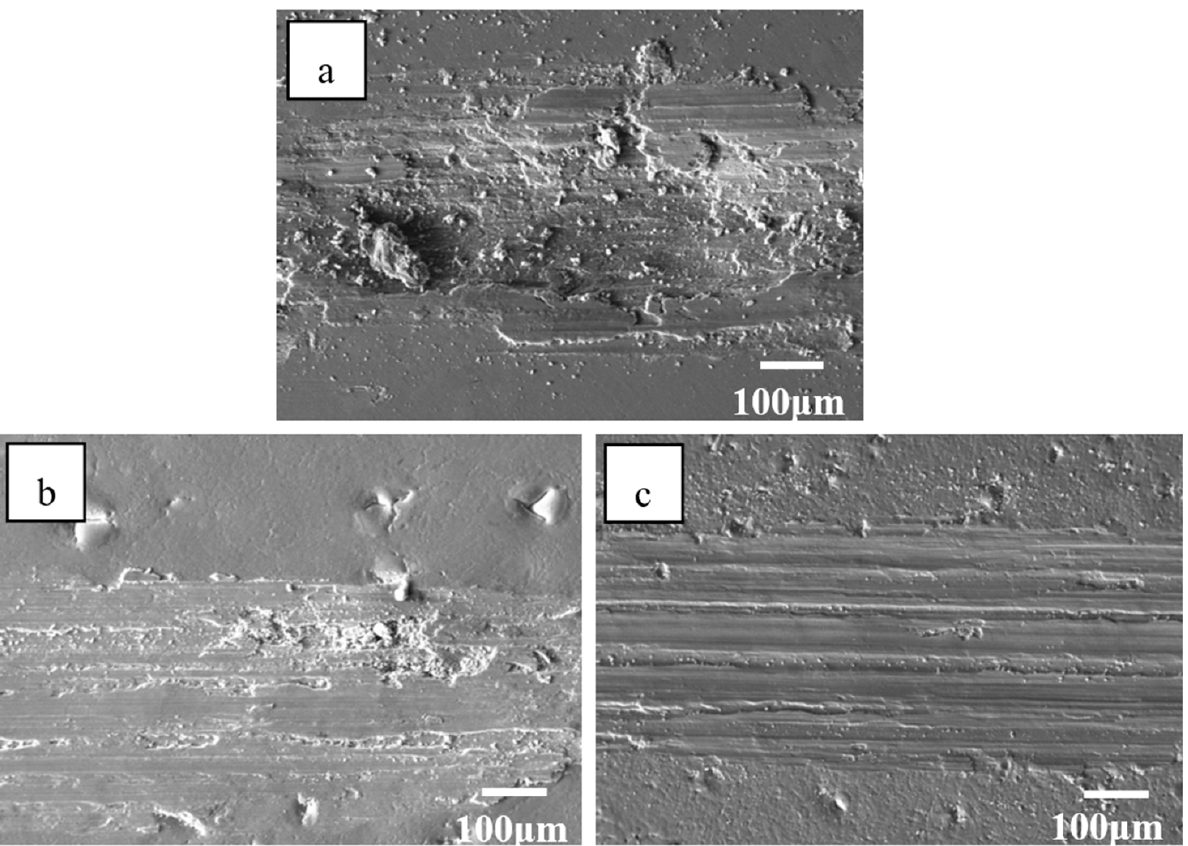
Figure 7. Friction surface morphology of Al–17.5Si and Al–17.5Si–0.3Nd alloys before and after HCPEB treatments. ( a ) Al–17.5Si alloy, original specimen; ( b ) Al–17.5Si alloy, 25 pulses; ( c ) Al–17.5Si–0.3Nd alloy, 25